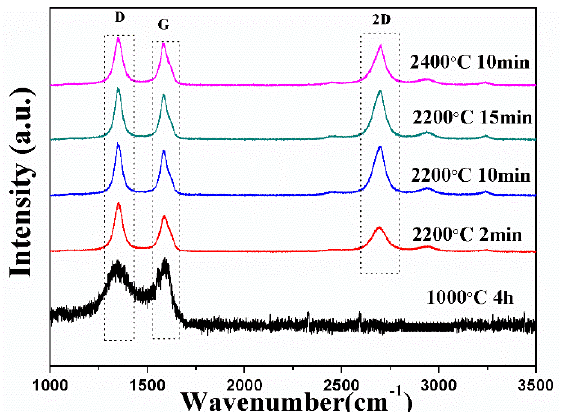
Figure 2. Raman spectra of wood-derived biocarbon prepared at different temperatures and dwell times.